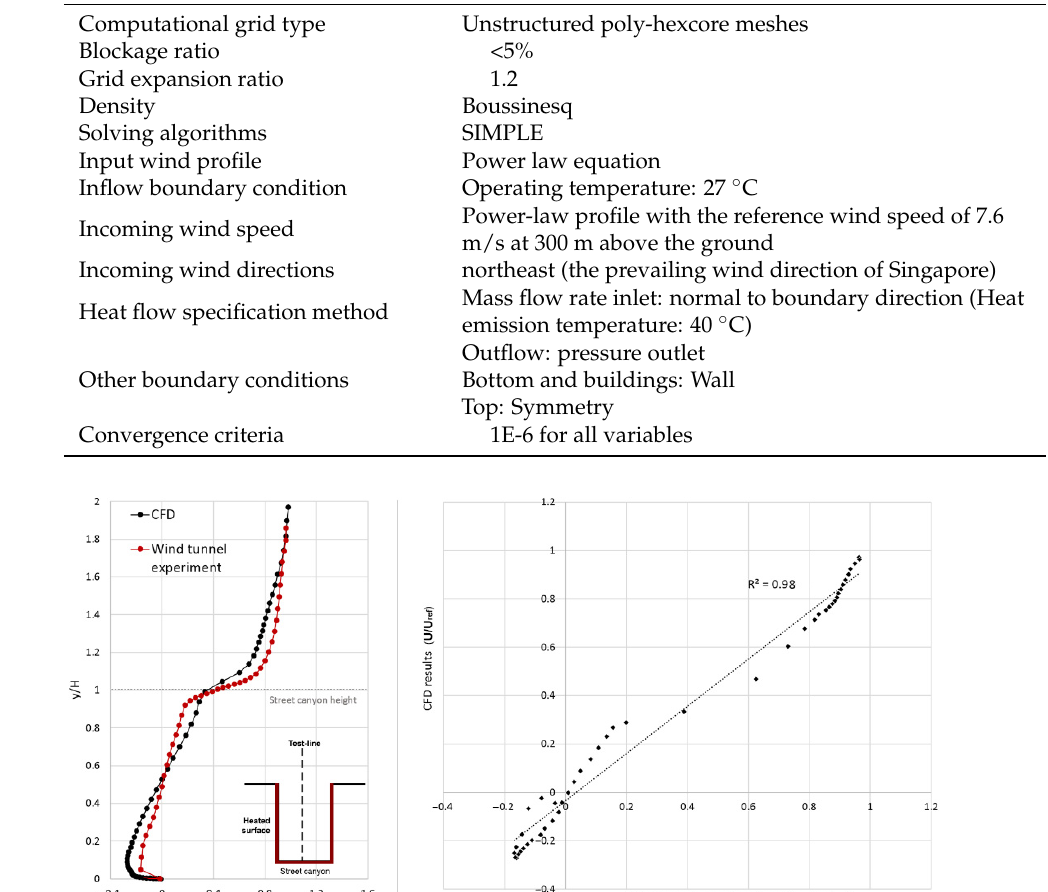
Table 2. CFD simulation settings.